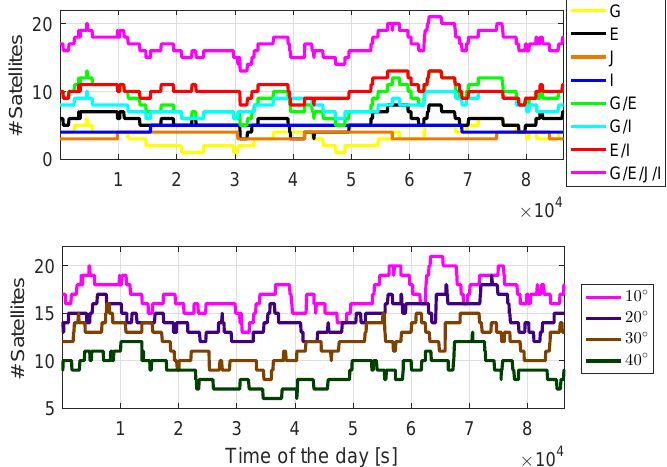
Figure 1. Number of visible satellites from different systems with an elevation mask of 10 degrees ( top ) and from all the four systems with different elevation masks ( bottom ). The figures were generated based on the MGEX combined broadcast ephemeris on DOY 224, 2018 for station CUAA located in Perth, Australia. G, E, J and I are denoted as system identifications for GPS, Galileo, QZSS and IRNSS,